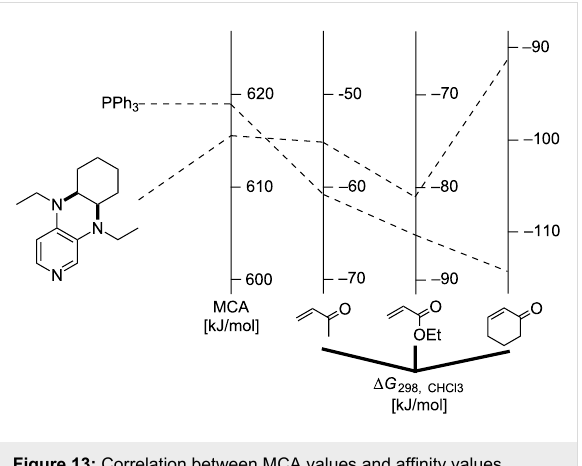
Figure 13: Correlation between MCA values and affinity values towards three different Michael